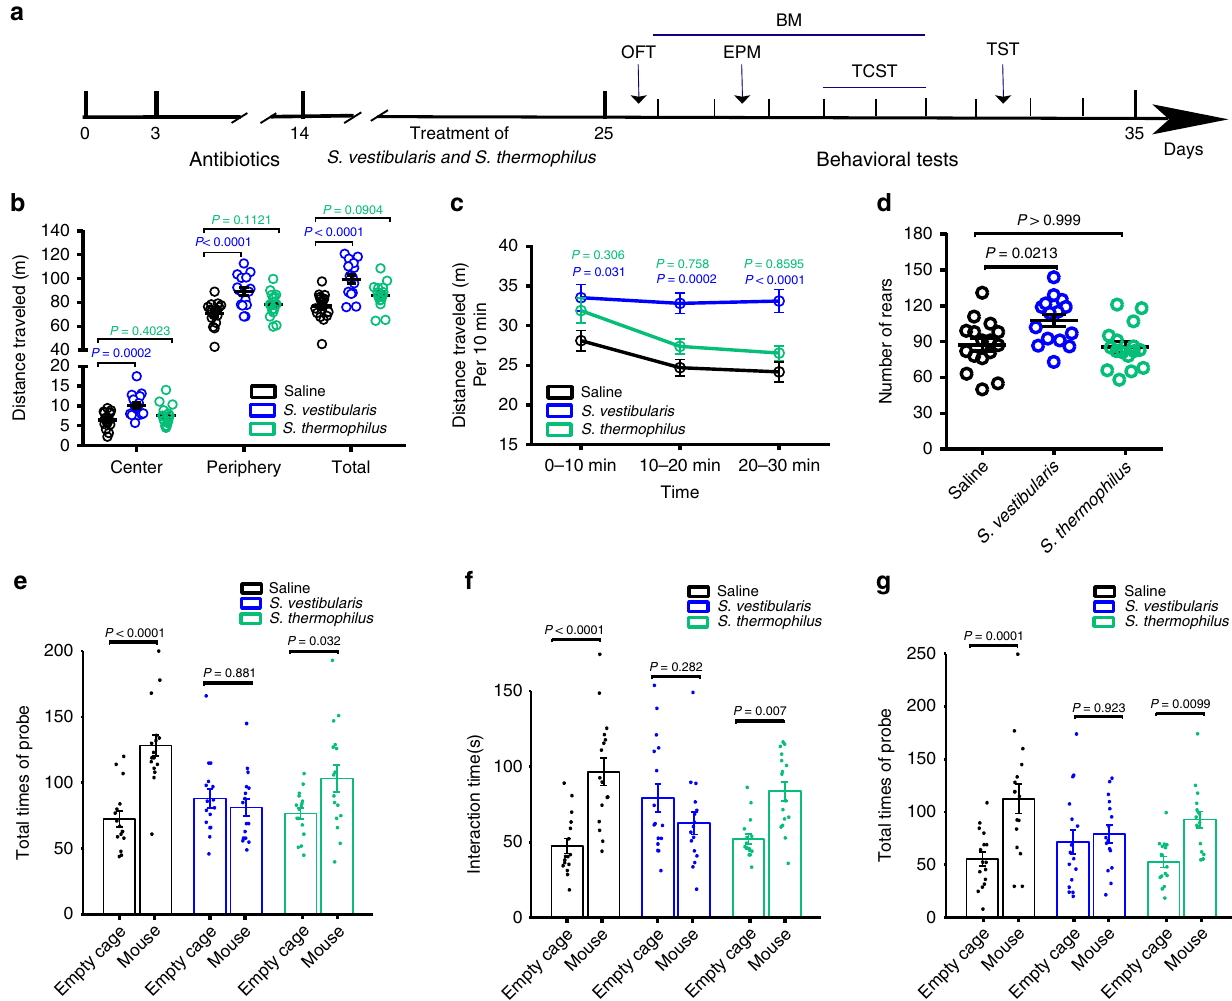
Fig. 4 Streptococcus vestibularis induces hyperkinetic behavior and impaired social interaction in mice. a Schematic diagram of bacterial transplantation and behavioral tests. b The cumulative distance (meters) in different zones in 30-min Open fi eld test (OFT) in the three groups of mice with oral gavage of Streptococcus vestibularis , S. thermophilus , and saline, respectively. c the cumulative distance (meters) in every 10-minutes time interval of OFT traveled and d the number of rearing by S. vestibularis -gavaged mice compared to mice gavaged with S. thermophilus and control mice. e – g three-chamber social test (TCST) comparing sociability of S. vestibularis -gavaged mice to that of S. thermophilus -gavaged mice and control mice. The results show that S. thermophilus - gavaged mice and saline-gavaged mice display obvious sociability, i.e., demonstrate an increase in the number of times probing a mouse ( e , P < 0.0001) and spending longer time interacting with a mouse ( f , P = 0.002) compared to an empty cage, and obvious social novelty, i.e., spending longer time interacting with an unacquainted mouse (new mouse; g , P = 0.005) in comparison with an acquainted mouse. However, these types of social behaviors were not observed in S. vestibularis -gavaged mice (for sociability: e , P = 0.881; f , P = 0.282; for social novelty, g , P = 0.923). The data are representative of two independent experiments and are presented as means ± SEM ( n = 16 S. vestibularis -gavaged mice or S. thermophiles -gavaged mice, 17 saline-gavaged mice per independent experiment in OFT; n = 16 mice/group/independent experiment in TCST). The circle represents one value from individual mice ( b , d , e – g ). P -values were determined by one-way analysis of variance (ANOVA) ( b ), repeated measure two-way ANOVA followed by Sidak ’ s multiple comparisons test ( c ; Blue P : S. vestibularis -gavaged versus saline-gavaged mice; green P : S. thermophilus -gavaged versus saline-gavaged mice), two-sided Kruskal-Wallis test followed by Dunn ’ s multiple comparisons test ( d ), or two-way (ANOVA) followed by Sidak ’ s multiple comparisons test ( e – g ). See detailed statistical data in supplementary Source Data fi